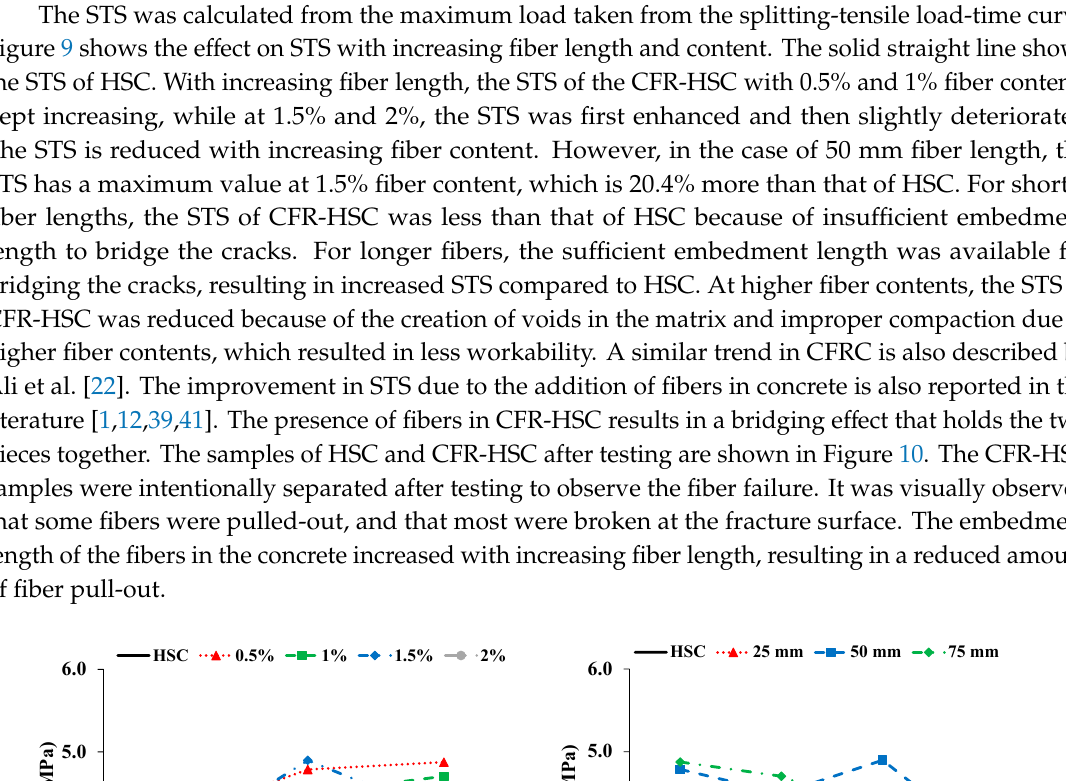
Figure 10. HSC and CFR-HSC specimens after STS test. 3.5. Flexural Properties 3.5.1. Flexural Behavior During the flexural-strength testing of beams, flexural load-displacement curves were recorded for all specimens. The HSC beams suddenly fragmented into two pieces at peak load (Figure 11a). However, CFR-HSC were held together even after the peak load (Figure 11b–d). This is due to the bridging effect of the fibers in the CFR-HSC beams, which held the beam together after cracking. The flexural load-displacement curves for HSC and CFR-HSC are shown in Figure 12. To observe the fiber failure mode in CFR-HSC, the beams were intentionally broken into pieces. The fiber failures were of two types, fiber pull-out and fiber breakage. The fiber pull-out failure was reduced with increasing fiber length. The reason for this was that for shorter fiber lengths, the embedment length of the fiber in the concrete was shorter, resulting in increased pull-out failure; whereas for longer fibers, embedment length increases, thereby resisting the pull-out of fibers and resulting in increased fiber breakage failure.